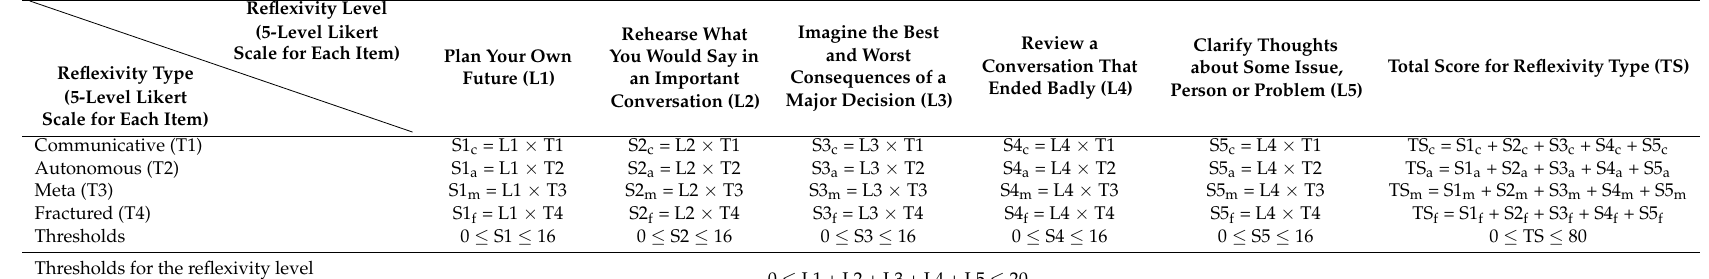
Table 2. Calculation of the reflexivity scores